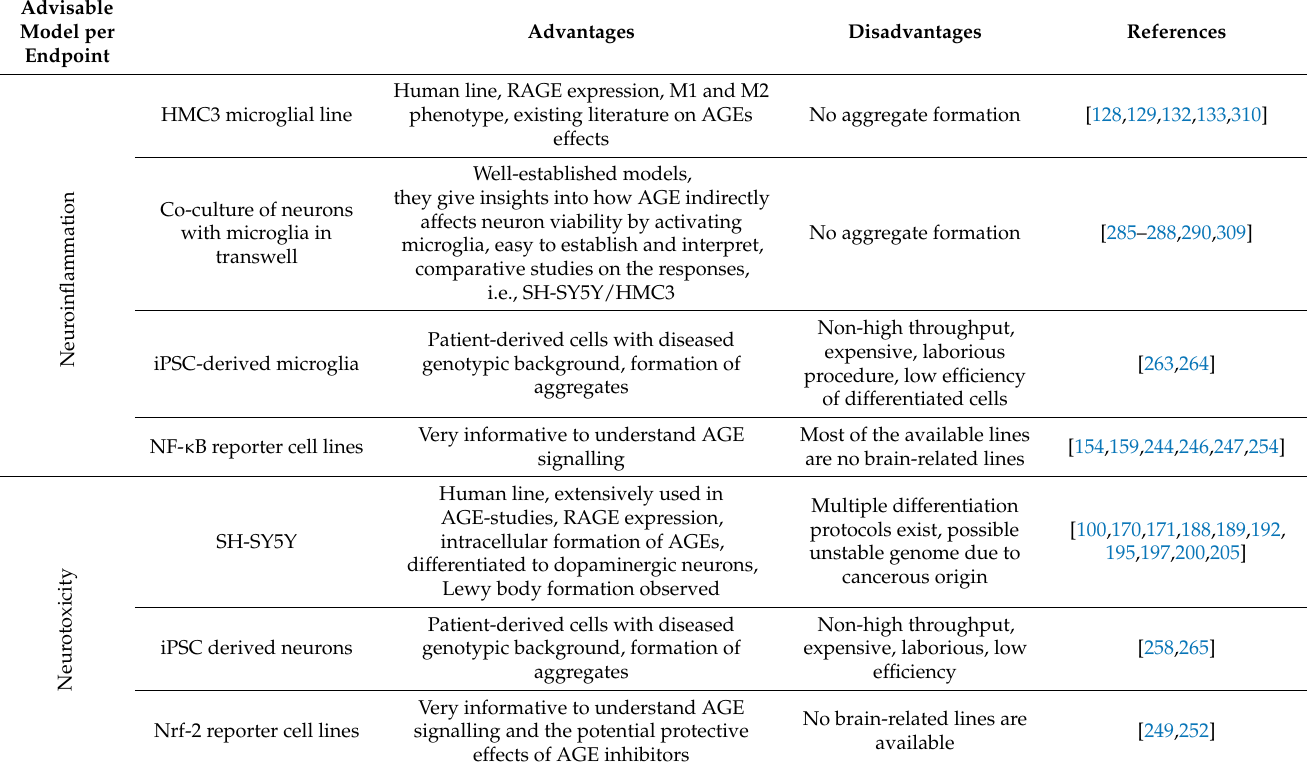
Table 2. The advisable in vitro models per endpoint of interest. The endpoints in which the role of AGEs in neurodegeneration can be studied are neuroinflammation, neurotoxicity, and